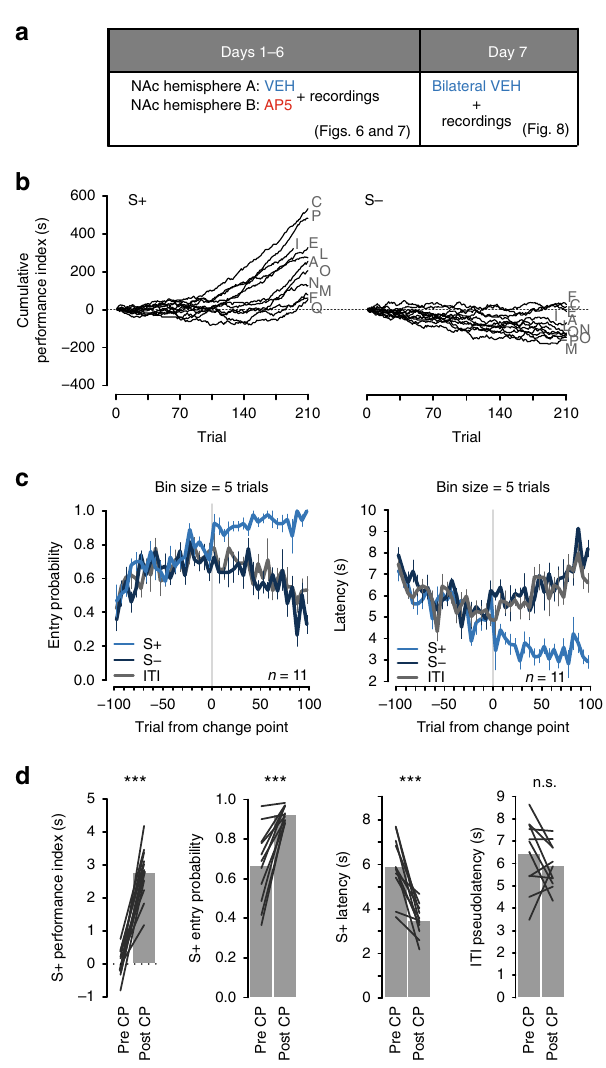
Fig. 6 Unilateral blockade of NMDARs in NAc core did not abolish learning in most subjects. a Microinjection schedule. VEH: vehicle. b Cumulative performance index records on S + (left) and S − (right) trials in 11 animals that, despite receiving unilateral intra-accumbens AP5 injections during training, were able to acquire cued approach behavior. Each subject ’ s behavior is represented by a black line. Letters identify different subjects. c Left: Mean ± SEM entry probability during the S + (light blue), S − (dark blue), or pre-cue 10 s ITI window (gray) with respect to the trial in which the change point occurred. Before change point, the overall rate of receptacle entry shows a steady increase until, at the change point, the rate of cued entry continues to increase while the rate of uncued entry stabilizes. Right: same as left panel but for latency and ITI pseudolatency. d In subjects that received unilateral AP5 injections prior to each training session, S + performance index and S + entry probability increased after change point (*** p < 0.001; t test). S + latency declined (*** p < 0.001; t test), while the ITI pseudolatency did not change after change point ( p = 0.241; t test); n.s. not signi fi